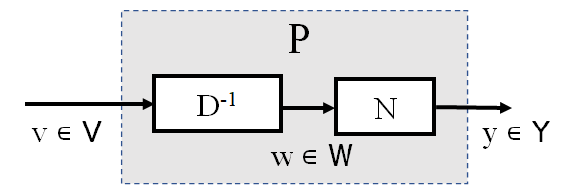
Figure 1. Right factorization of a nonlinear object.